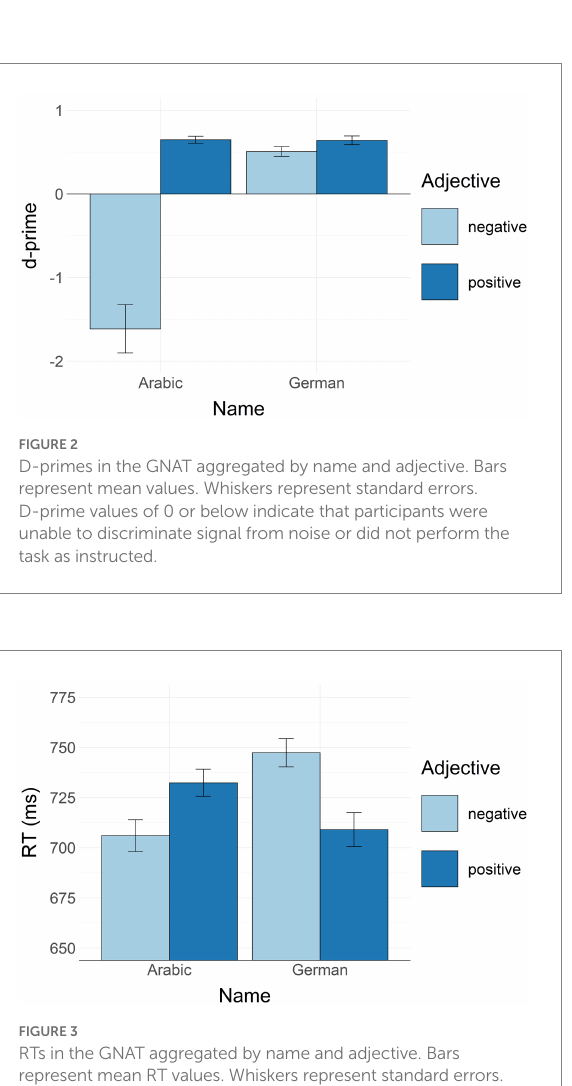
FIGURE 3 RTs in the GNAT aggregated by name and adjective. Bars represent mean RT values. Whiskers represent standard